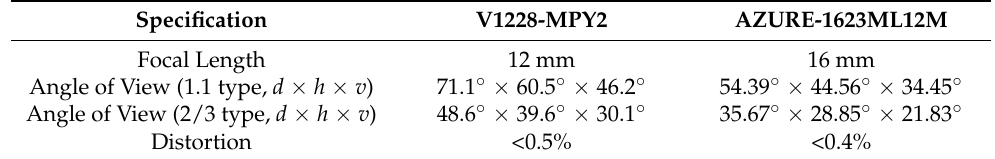
Table 3. Inspection camera specifications. Table 4. Inspection lens